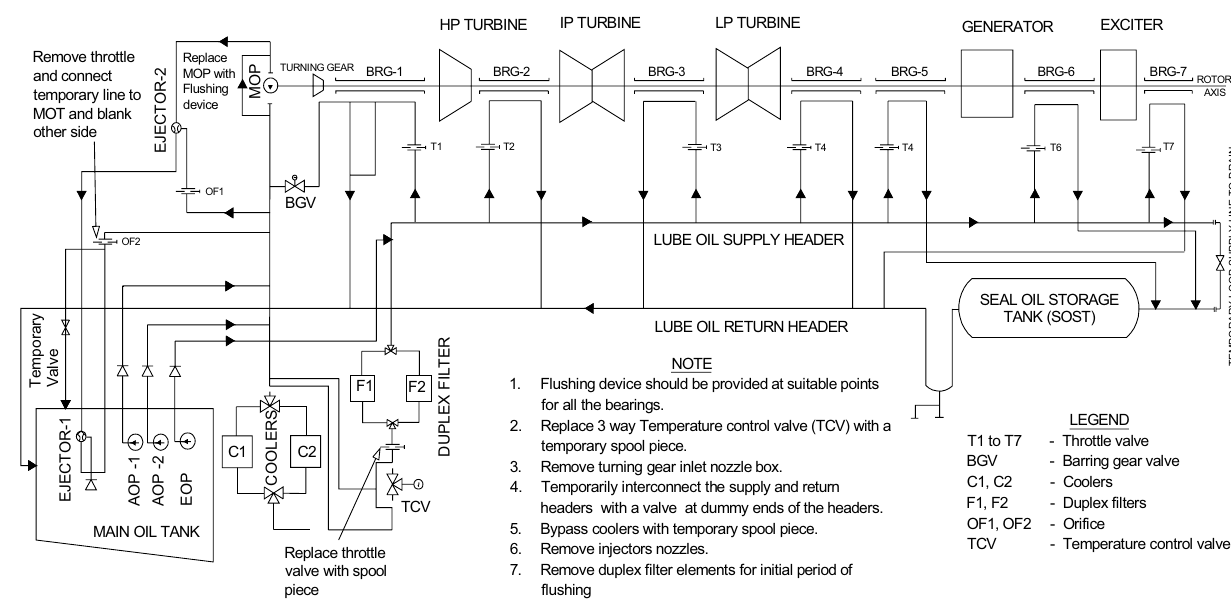
Fig. 1 Lube oil system flushing scheme